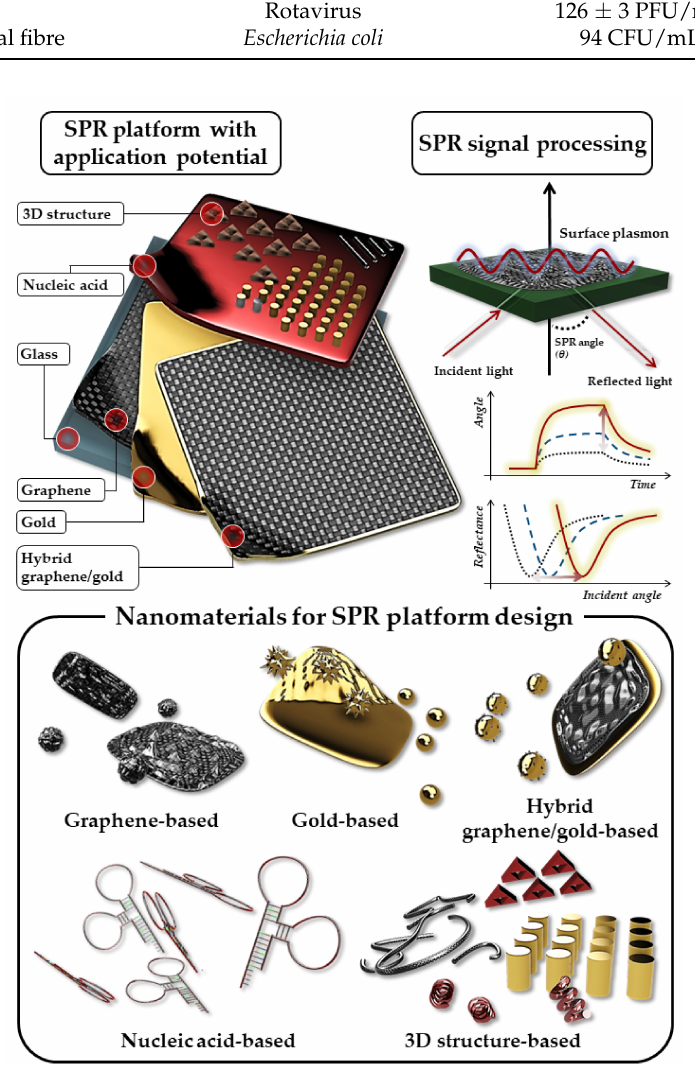
Figure 1. Schematic of recent advances in SPR sensor technology with various nanomaterials and applications for pathogen